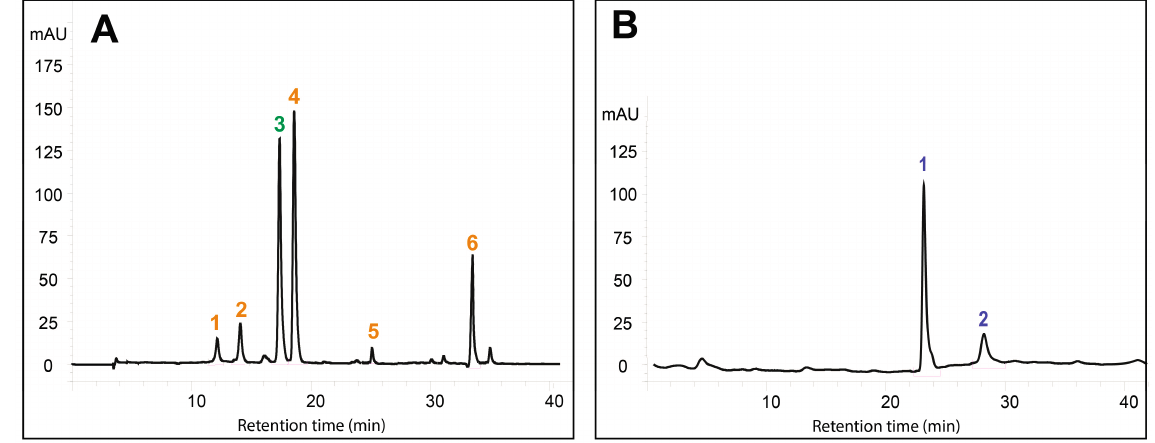
Figure 5. HPLC analysis of Artemisia annua suspension cell extracts recorded at 475 nm ( A ) and at 275 nm ( B ). Cells were treated with 50 mM DIMEB for three days. Peaks in ( A ) are (1) violaxanthin; (2) neoxanthin; (3) chlorophyll b; (4) lutein; (5) zeaxanthin; (6) β -carotene. Peaks in ( B ) are (1) Q9; (2)